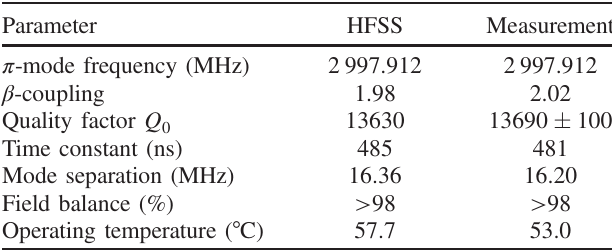
FIG. 14. Measured reflection coefficient ( j s 11 j ) as a function of frequency revealing the frequency spectrum of the SwissFEL gun. The operating frequency in vacuum is 2 997.912 MHz at 53°C. The frequency separation to the adjacent mode is